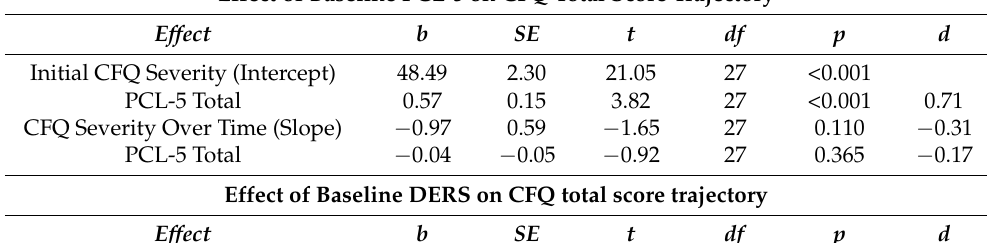
Table 7. Results of hierarchical linear models assessing the impacts of baseline variables on the trajectory of changes in subjective cognition and self-report symptom measures over time a . Effect of Baseline PCL-5 on CFQ Total Score